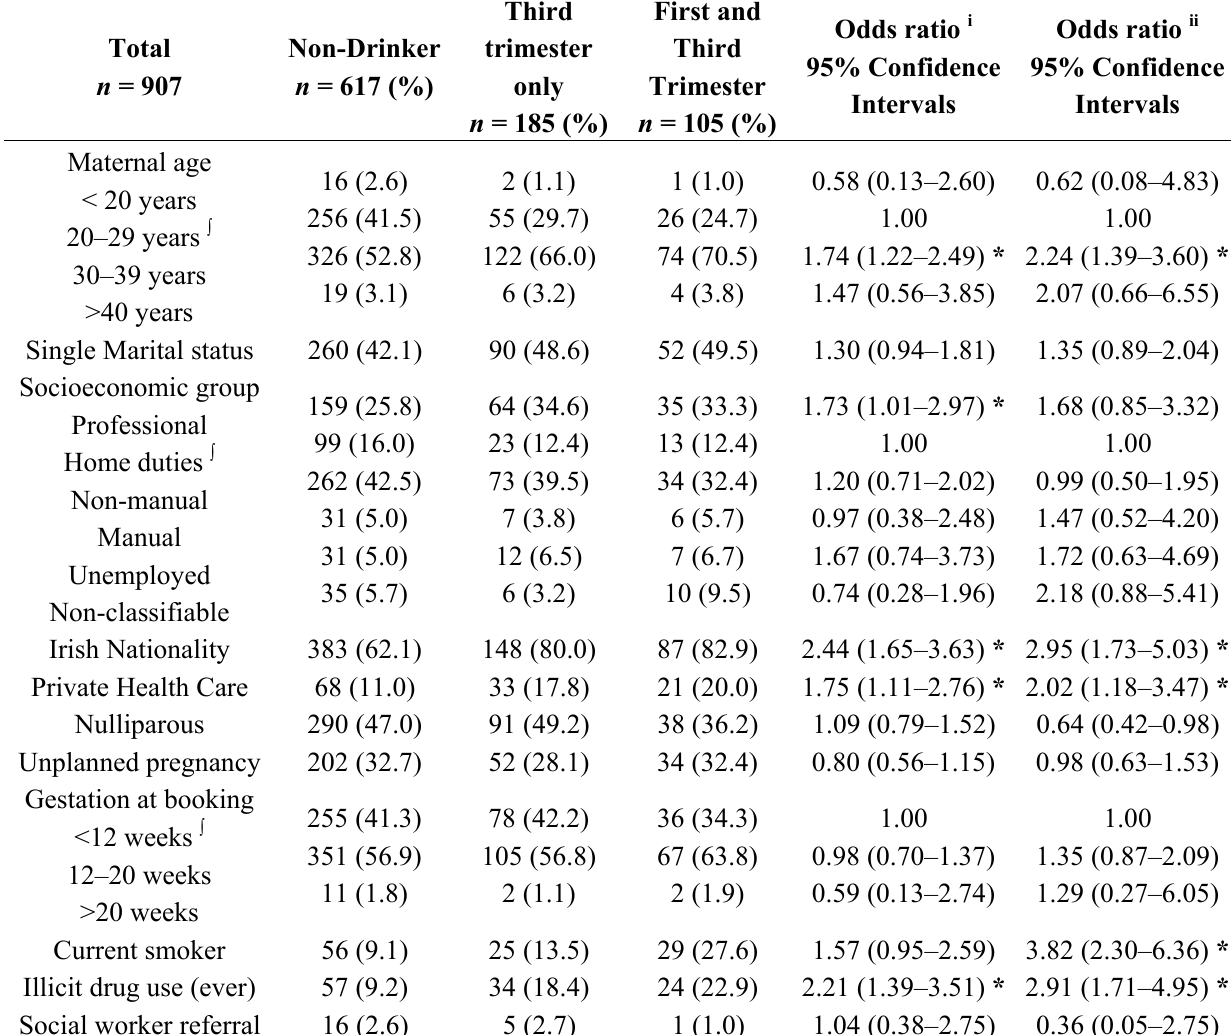
Table 3. Characteristics of women according to alcohol exposure in